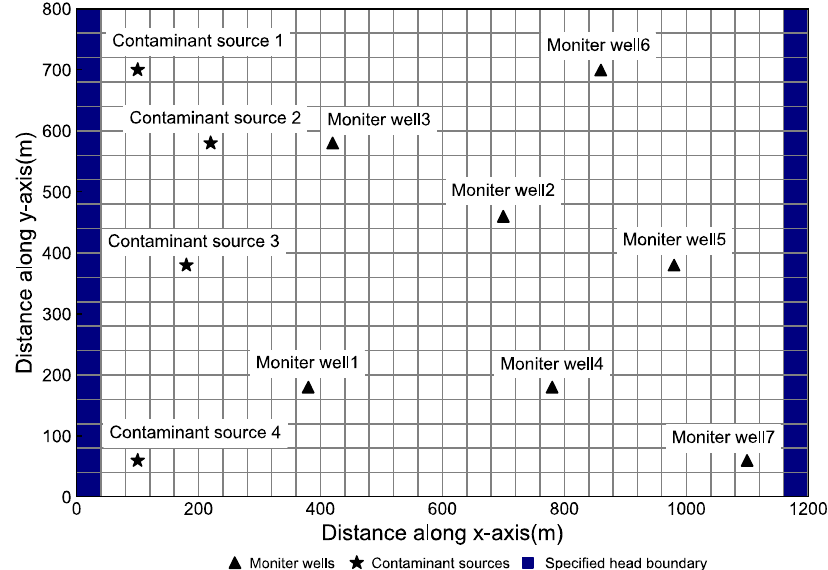
Figure 7. Basic information for case 2. Table 7. Hydrogeological parameters of case 2.